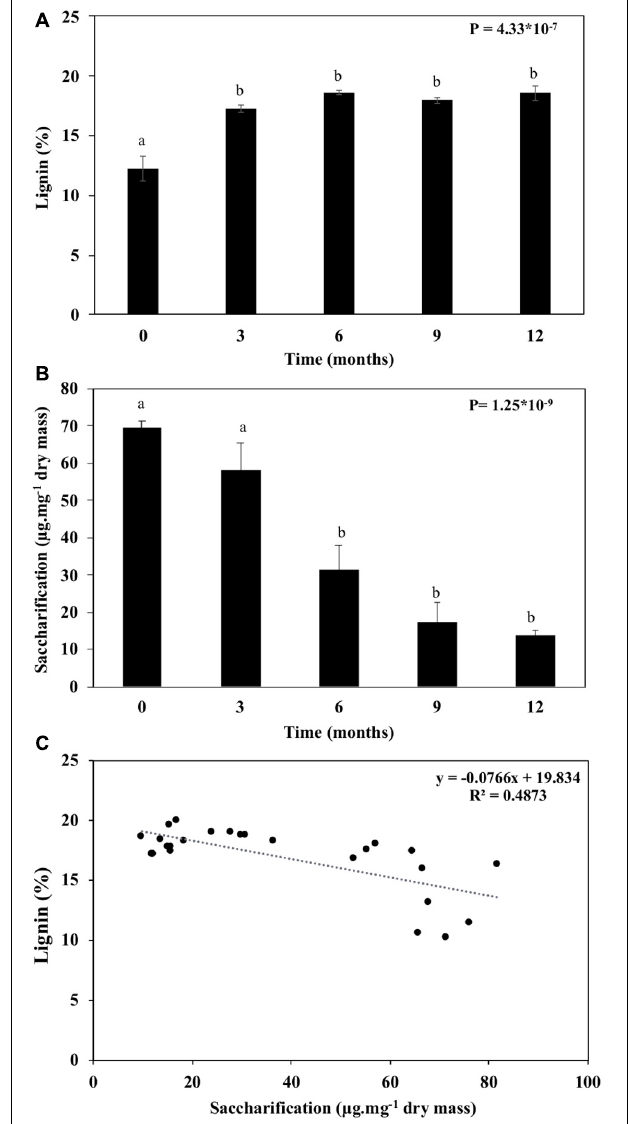
FIGURE 8 | Lignin and saccharification of the sugarcane straw maintained under field conditions for 12 months. (A) Lignin quantification. (B) Total cell wall saccharification. (C) Correlation between lignin content and saccharification of the sugarcane straw. Bars represent the average ± standard error. Different letters are significant differences by Tukey’s test ( P < 0.05; n =